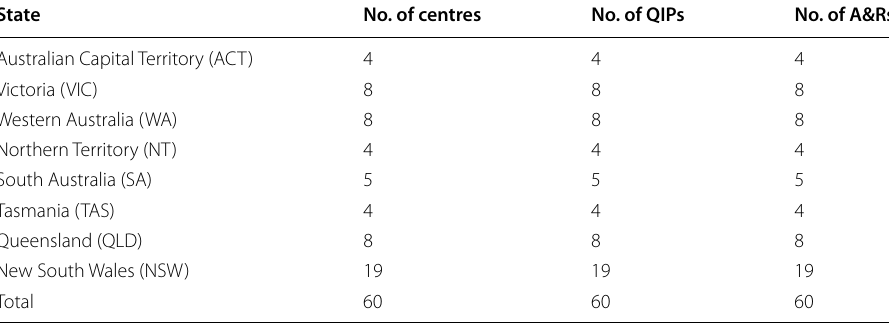
Table 1 Total number of documents analysed per State/Territory State No. of centres No. of QIPs No. of